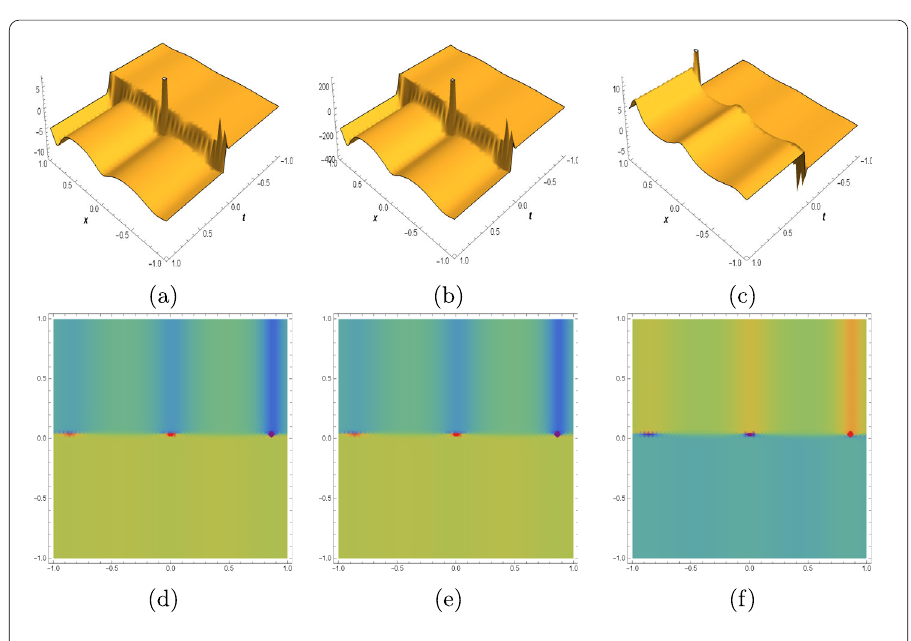
Figure 2 The 3D and density profiles of Eq. (8) for p 0 = –7.25, p 1 = –0.26, m 1 =